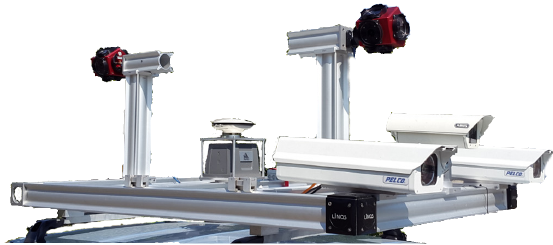
Figure 1. System overview demonstrating our novel stereo panorama camera